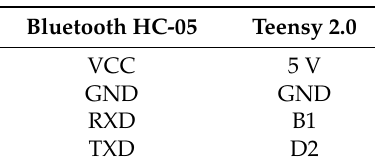
Figure 4. Portable foot attitude measuring device.